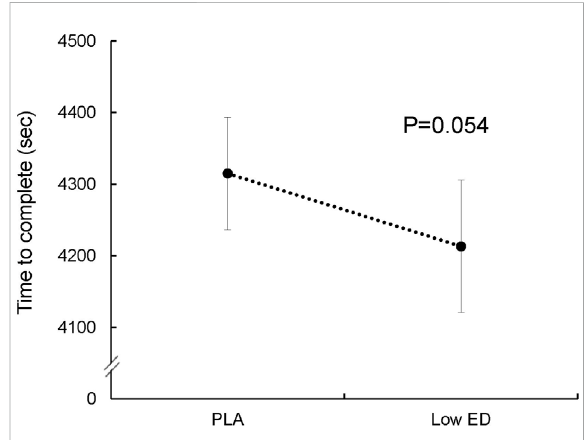
FIGURE 4 Sprint triathlon performance for nine subjects with placebo (PLA) and low-dosage energy drink (Low ED) group. (Except three subjects who may overdose). Values are expressed as mean ± SE.